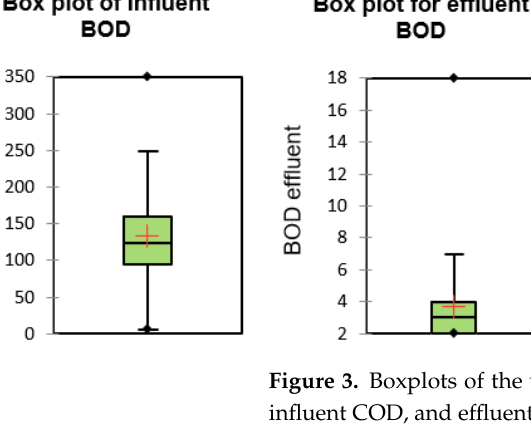
Figure 2. Wastewater Quality Index variation.